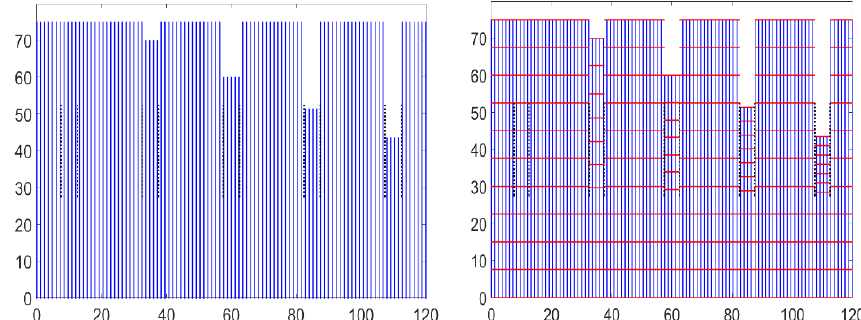
Figure 4. REV model showing impact of different natural fracture (NF) porosity on FP and TOF in a reservoir space of 5% porosity. NF porosity from left to right: NF 1 = 5% (NF 1 porosity same as reservoir), NF 2 = 6%, NF 3 = 8%, NF 4 = 10%, NF 5 = 15%. Streamlines in blue (left side) and TOF in red (right side). Far field flow of 2.5 ft/year scaled by reservoir porosity is used in all REV models.